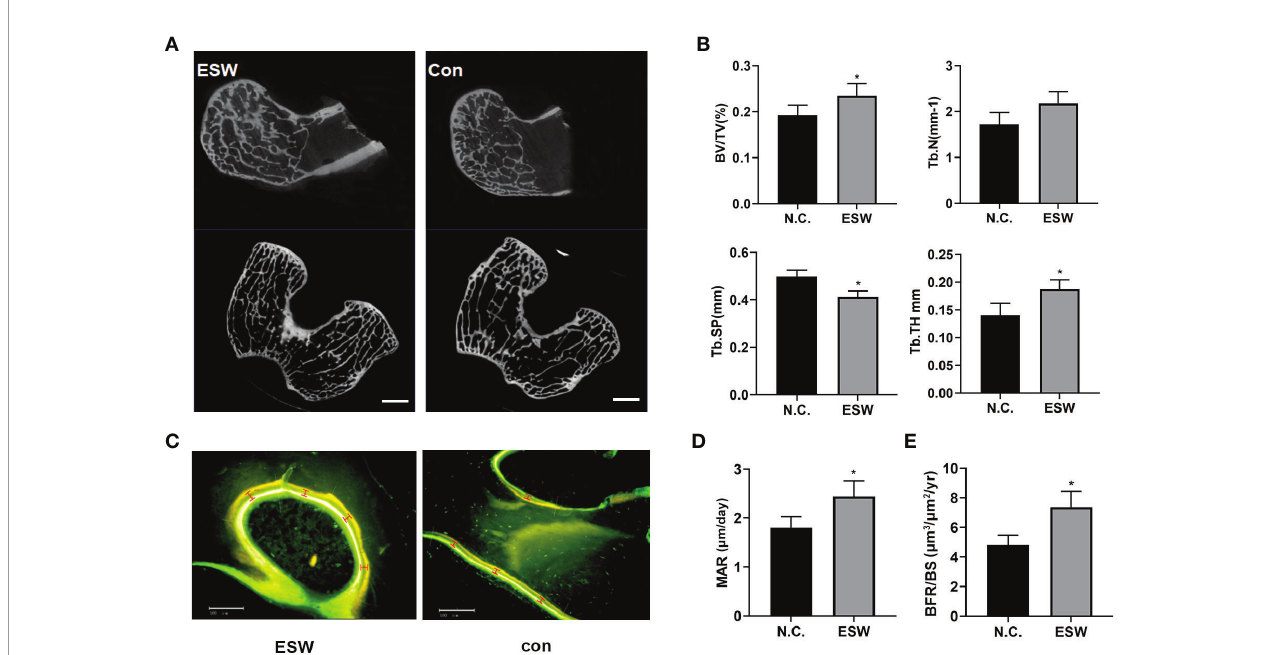
FIGURE 2 | ESW treatment increased bone formation in vivo . (A) Representative micro-CT images in femur from rabbits treated with ESW or Con. Scale bar: 500 m m. (B) Quantitative micro-CT analysis of femur from rabbits treated with ESW or Con. (C) Representative images of calcein (Green) and tetracycline (yellow) labeling of trabecular bone from rabbits treated with ESW or Con. Scale bar: 500 m m. (D) the mineral apposition rate (MAR) and (E) the quanti fi cation of the BFR per bone surface (BFR/BS) of the femur from rabbits treated with ESW or Con. (n = 7, per group). Data are reported as the mean ± SD. *p <